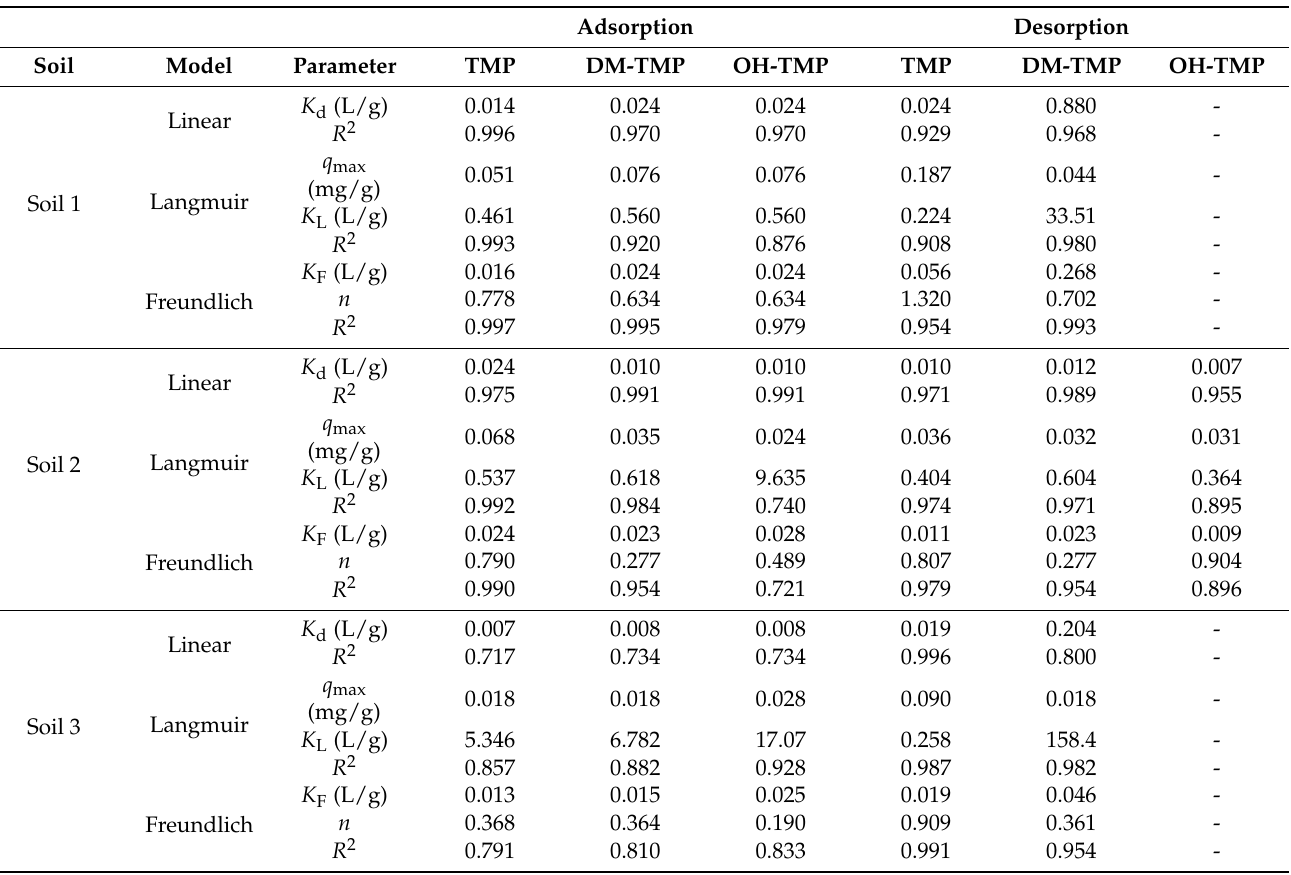
Table 2. Experimental adsorption and desorption parameters isotherms of TMP and its metabolites in the